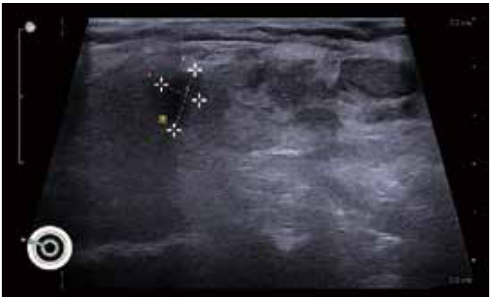
Figure 4 Three-dimensional TRUS at axial view at the middle level of anal canal demonstrated that the abscess was mainly located in the intersphincteric space from 7 to 1 o’clock.